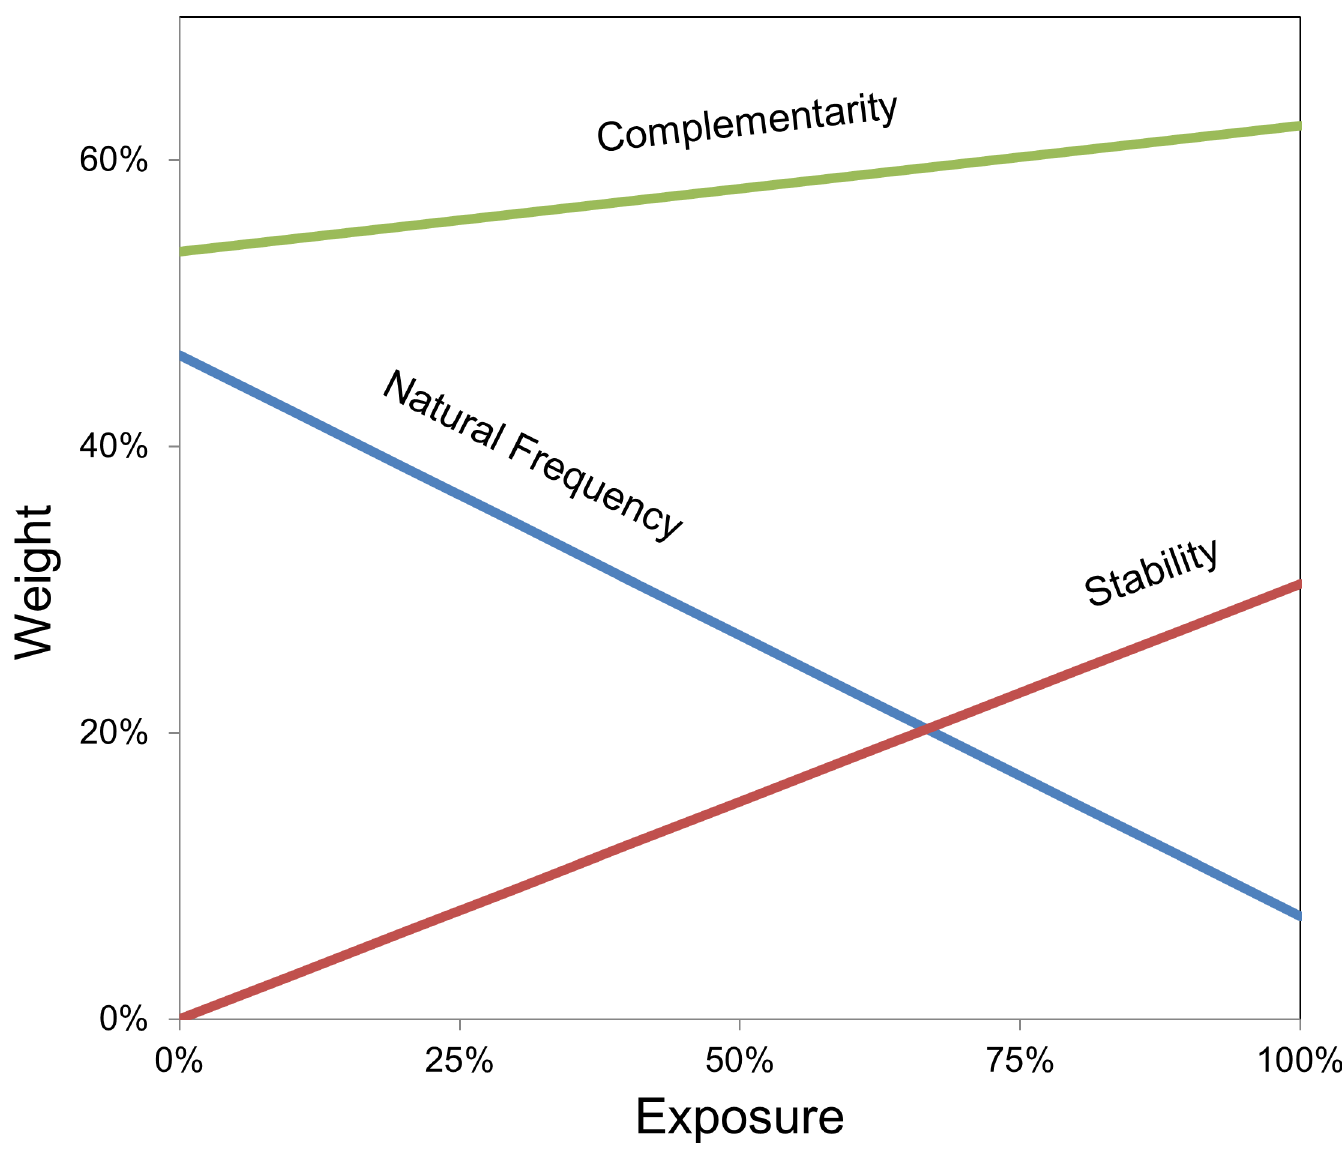
Fig 9. Correlative parametric analysis of amino acid distributions. Sitewise evaluation of theoretical stability upon mutation and natural sequence frequency, as well as overall amino acid prevalence at binding interfaces of antibodies (i.e. complementarity), generate sitewise amino acid frequencies. The ability of these frequencies – scaled linearly based on solvent exposure and target exposure (Eq 1 and S3 Fig) – to collectively mimic the observed sitewise amino acid distributions in binding populations is evaluated. The optimal weights for each contributing data set as a function of exposure are